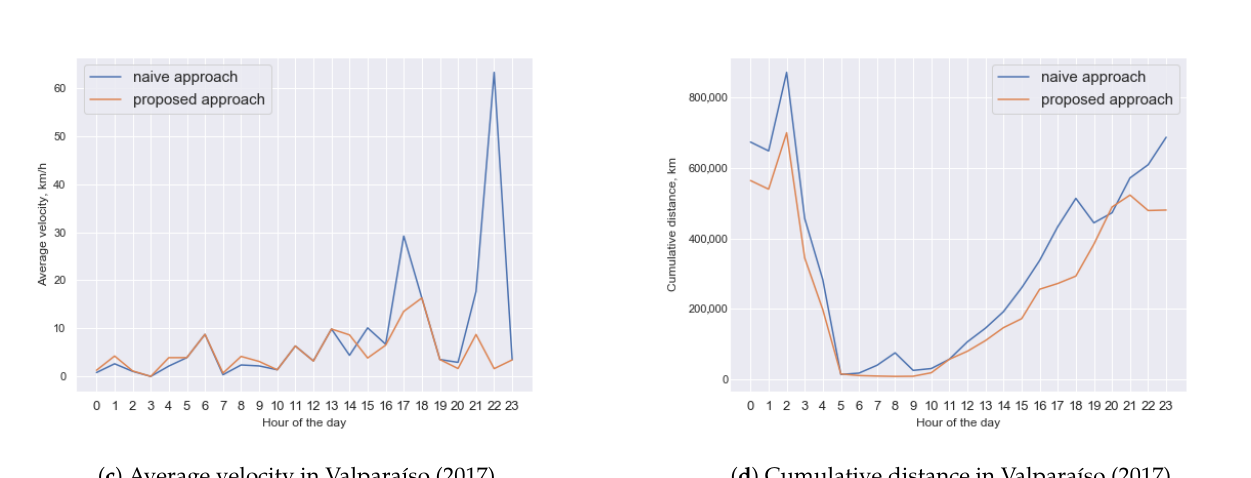
Figure 16. Naive and proposed approaches evaluated on subsets of data for 1 January 2018, and 6 March 2017 in Valparaíso. When we analyze subsets of sites with a high rate of NNHs, the accumulated distances have important deviations in the naive